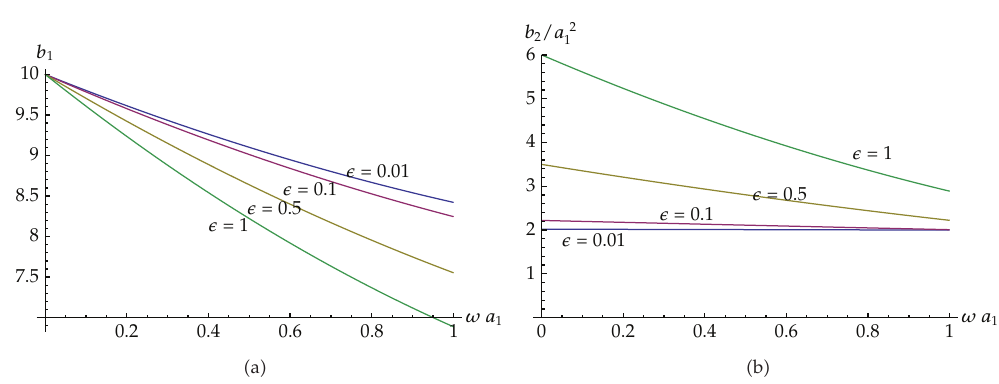
Figure 2: (cid:2) Color online (cid:3) D (cid:8) 6, g (cid:8) 0, (cid:2) j,m 1 ,m 2 ,n 1 ,n 2 (cid:3) (cid:8) (cid:2) 0 , 1 , 1 , 0 , 0 (cid:3) : A plot of the eigenvalues for various choices of (cid:23) ≡ a 2 /a 1 . Note that the dependence on a 1 has been scaled into the other quantities.